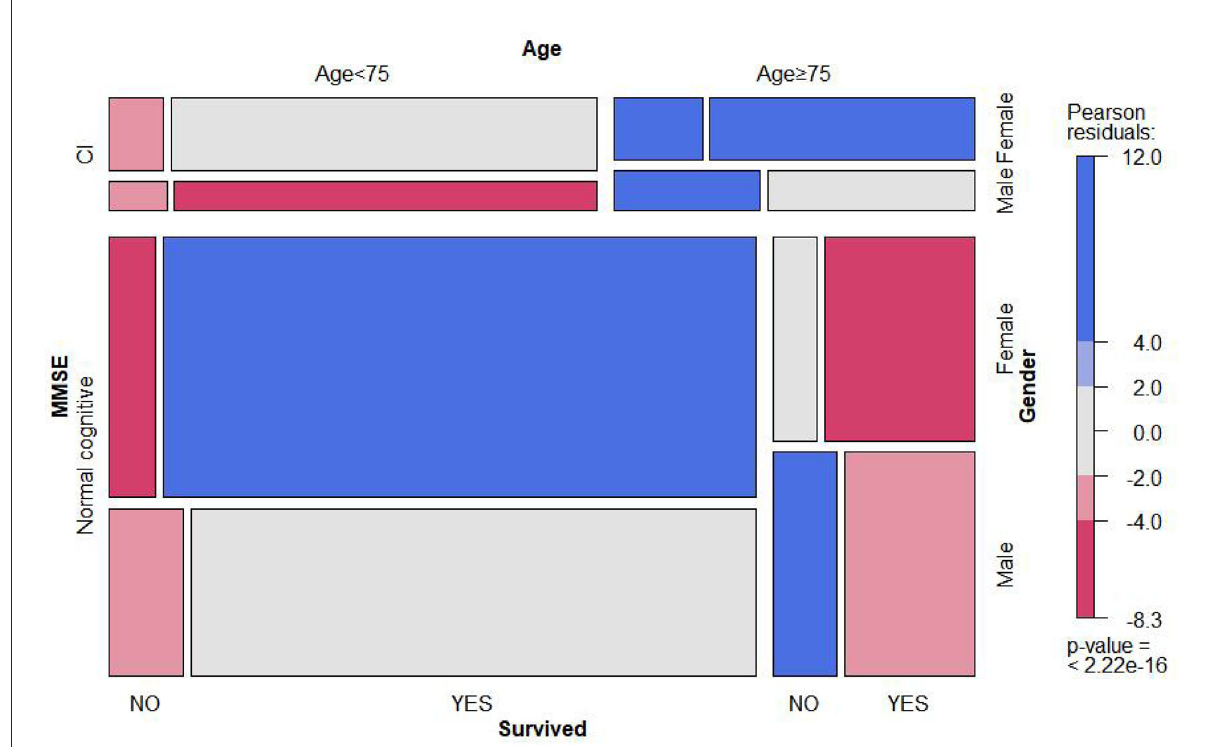
FIGURE2 Mosaic matrix for MMSE, age, gender, and survival state. It is mainly used to visually display the observation frequency and proportion of combination of two or three classification variables in different dimensions. The specific value is seen as attachment Supplementary Table S3.